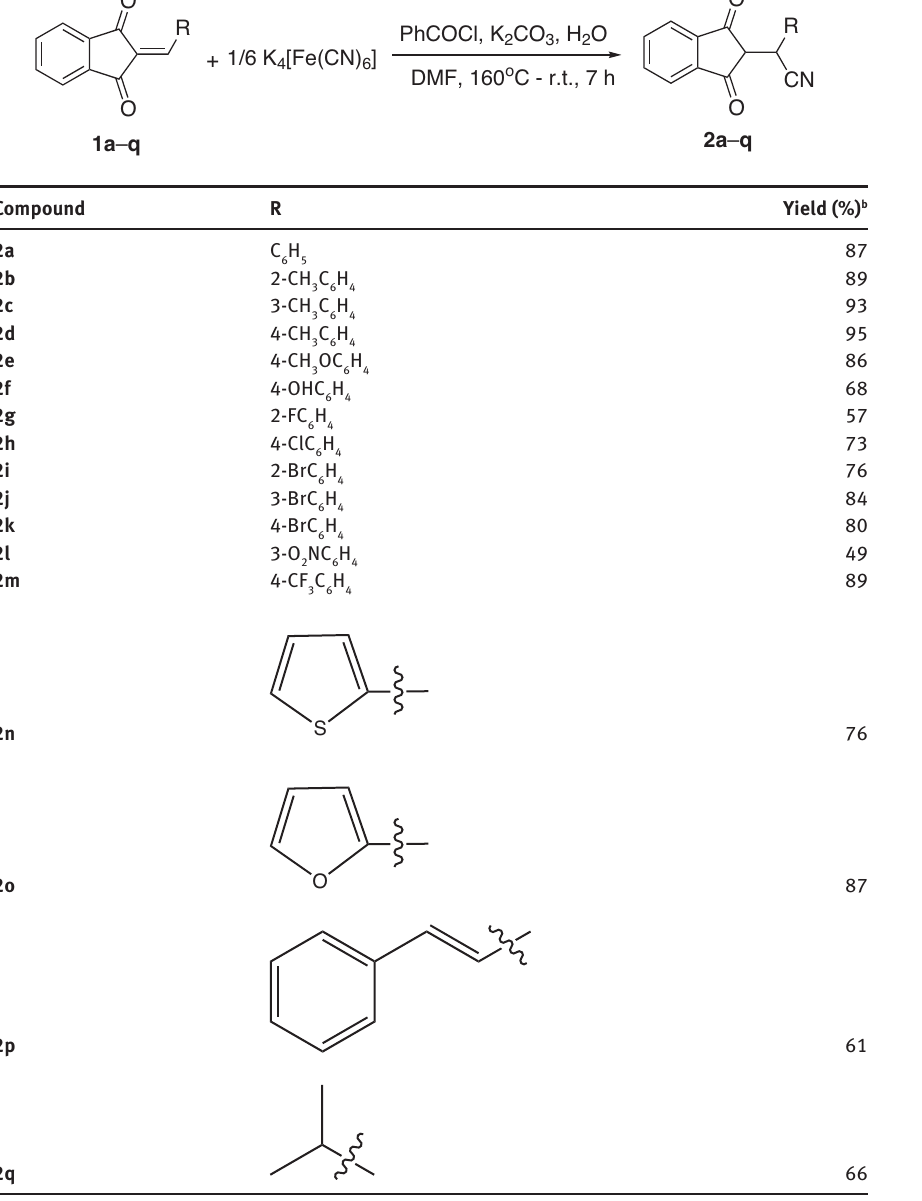
Table 2: The scope of 2-arylmethyleneindan-1,3-diones for the hydrocyanation. a